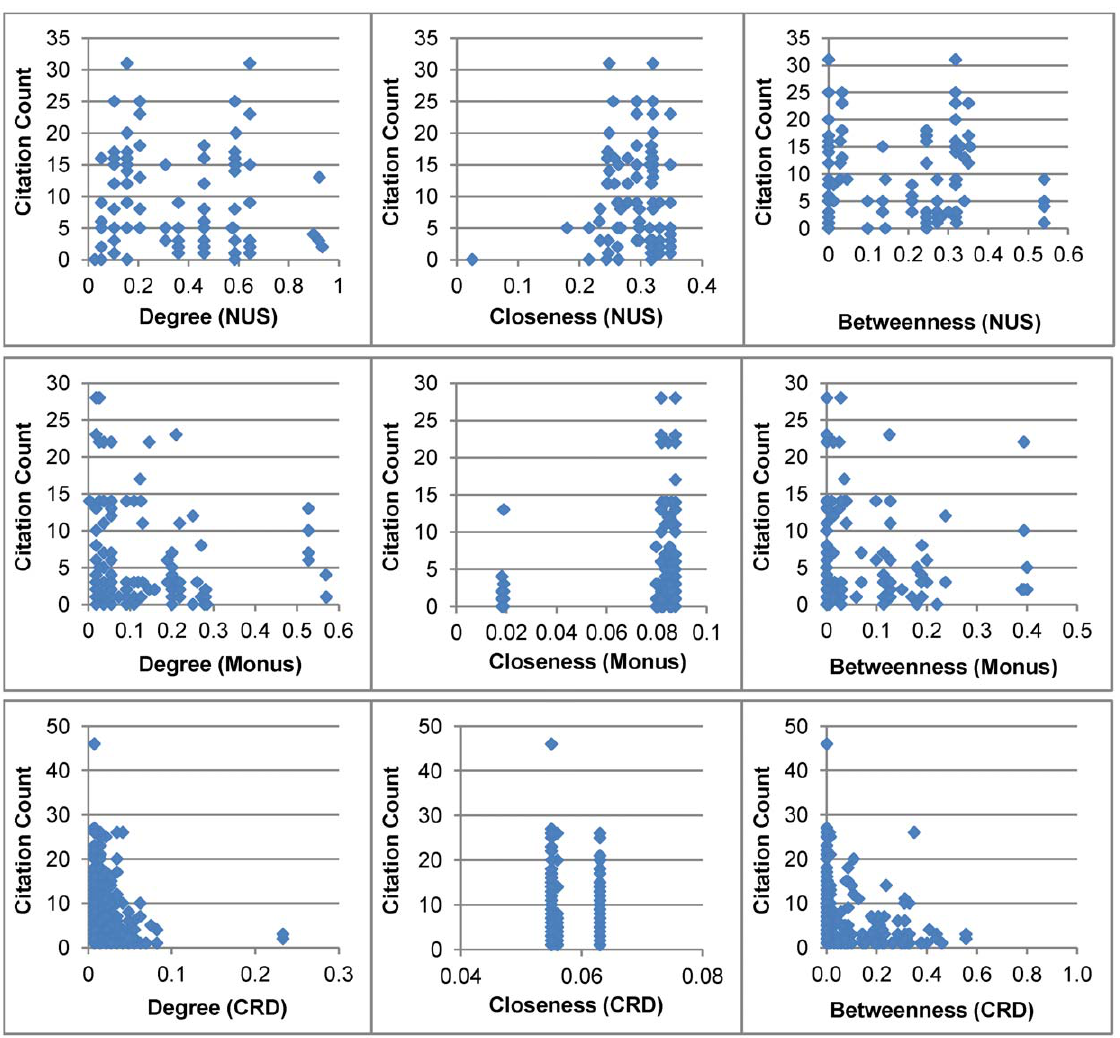
Figure 4. Network attributes for each author and the corresponding citationcount of the paper. Three basic centrality measures (i.e., degree centrality , closeness centrality and betweenness centrality ) are considered. CRD stands for ‘ Complete Research Dataset ’.